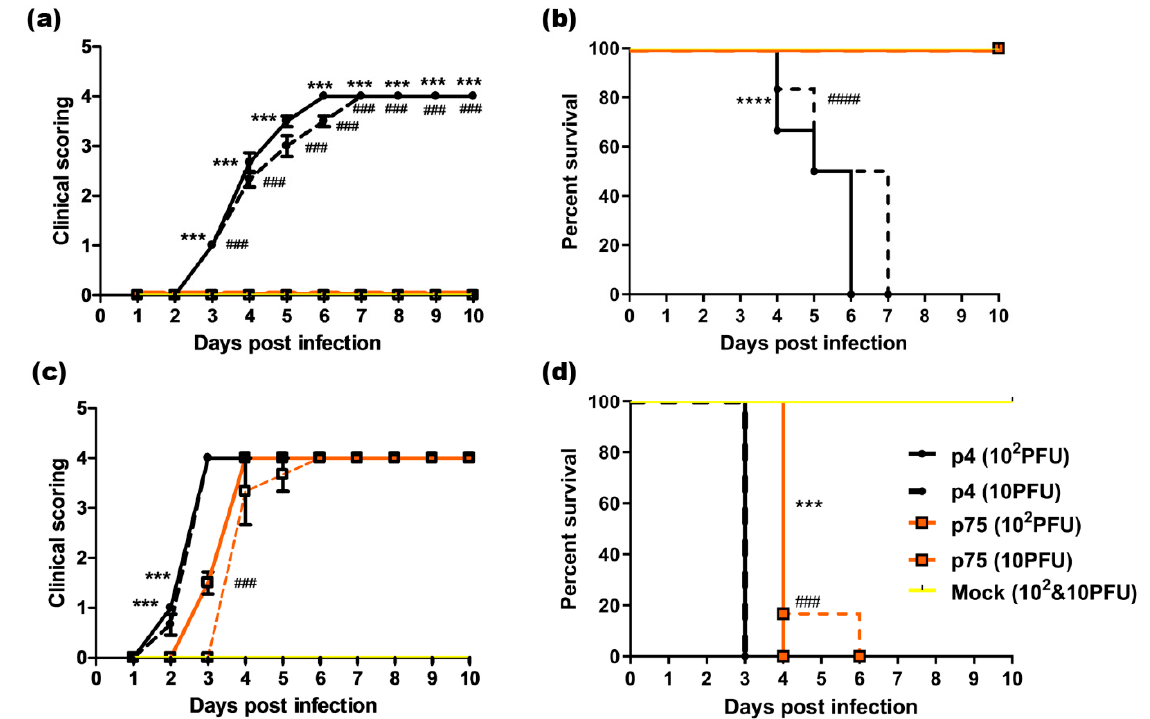
Figure 2. In vivo evaluation of infectivity of p4 and p75 CHIKV strains in susceptible mice. Neonatal, 3-day-old BALB/c mice (n = 24/group) as well as 3- to 4- week-old AG129 mice (n = 6/group) were infected subcutaneously with 10 2 (solid line) and 10PFU (dashed line) of p4 and p75. Mock-infected group received the same amount of DMEM (n = 24/gp for BALB/c and 6/group for AG129) and is shown in yellow line with a dash. Data were pooled from 3 independent experiments and are pre- sented as the means ± SEM. ( a ) Clinical scoring of infected BALB/c mice. The appearance of signs of disease in mice was monitored daily. Clinical score scale: 0—normal behavior, 1—generalized cachexia, 2—walking difficulty and patchy alopecia, 3—epileptic seizures and ataxic gait, and 4—dead. Two-way ANOVA with Bonferroni test to compare the replicate means by row was applied. *** p value corresponds to p < 0.001 (p4 vs. p75 inoculated with 10 2 PFU) and ### p value corresponds to p < 0.001 (p4 vs. p75 inoculated with 10 PFU). ( b ) Survival graph of infected BALB/c